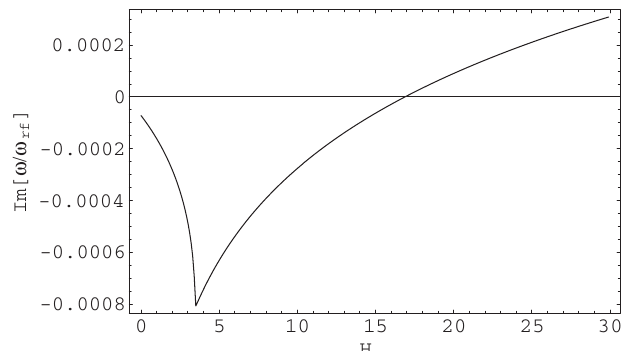
(cid:1) ! (cid:2) as a function of c